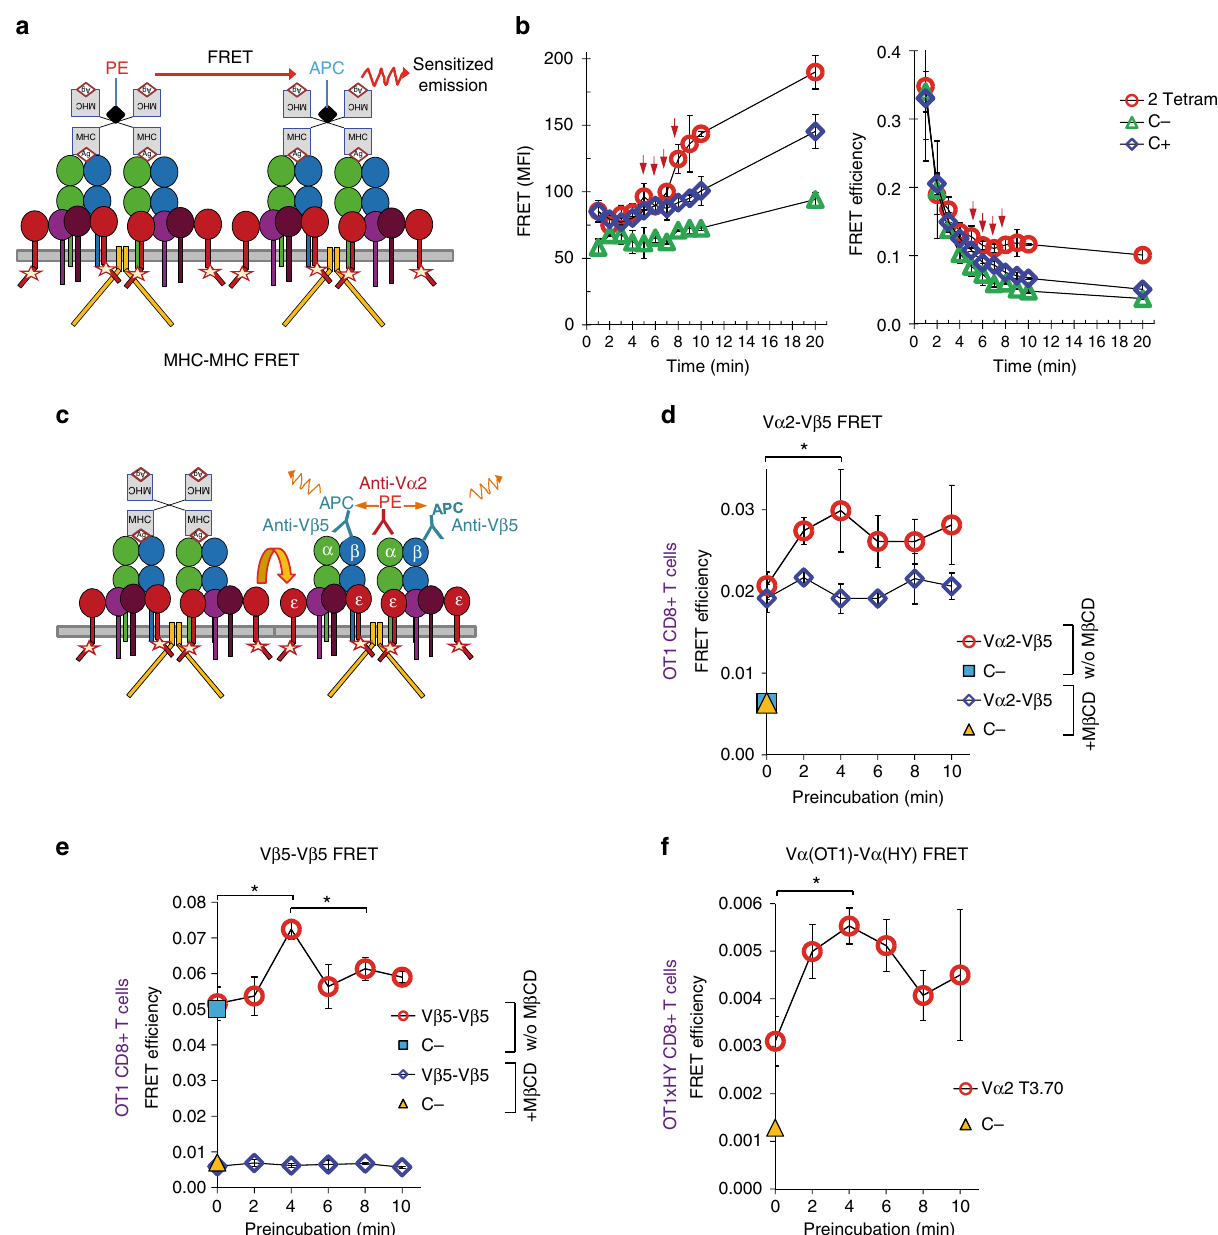
Fig. 6 Ligand binding induces changes in the proximity or orientation of TCRs within nanoclusters. a Schematic of the experimental set-up of Fig. 6b. FRET changes were detected upon simultaneous binding of PE- and APC-labelled OVAp tetramers. b CD8 + OT-1 T cells were incubated on ice with 5 nM each of OVAp-PE and OVAp-APC tetramers for the indicated times and fi xed. FRET intensity and ef fi ciency (left and right panels) were measured by fl ow cytometry. For FRET controls, OT-1 T cells were incubated with 5 nM of the OVAp-PE tetramer for the indicated times and, after fi xation, cells were further incubated for 50 min with either APC-labelled anti-CD3 (positive control, C + ) or APC-labelled anti-CD27 (negative control, C-) at saturating concentrations. Arrows indicate the time points at which an upward tendency of the FRET slope was noticed. c Schematic of the experimental set-up in d – f . FRET changes were detected in CD8 + OT-1 T cells that bound PE-labelled OVAp tetramer and APC-labelled anti-V β 5 antibody. d – f CD8 + OT-1 or OT-1xHY T cells pretreated or not with 10 mM M β CD for 30 min at 37 °C and subsequently were incubated at 0 °C with 1 nM unlabelled OVAp tetramer for the indicated times. After fi xation, they were incubated for 50 min with anti-V α 2-PE and anti-V β 5-APC ( d ), anti-V β 5-PE and anti-V β 5-APC ( e ) or anti-T3.70-PE and V α 2-APC ( f ). For all antibody combinations, a negative control is included using the donor antibody and anti-CD27-APC (C-). FRET ef fi ciency is calculated as described in the Methods section and represented versus time of preincubation with tetramer. All data shown in Fig. 6 represent the mean ± s.d. of triplicate datasets; * p < 0.05 (2-tail unpaired t